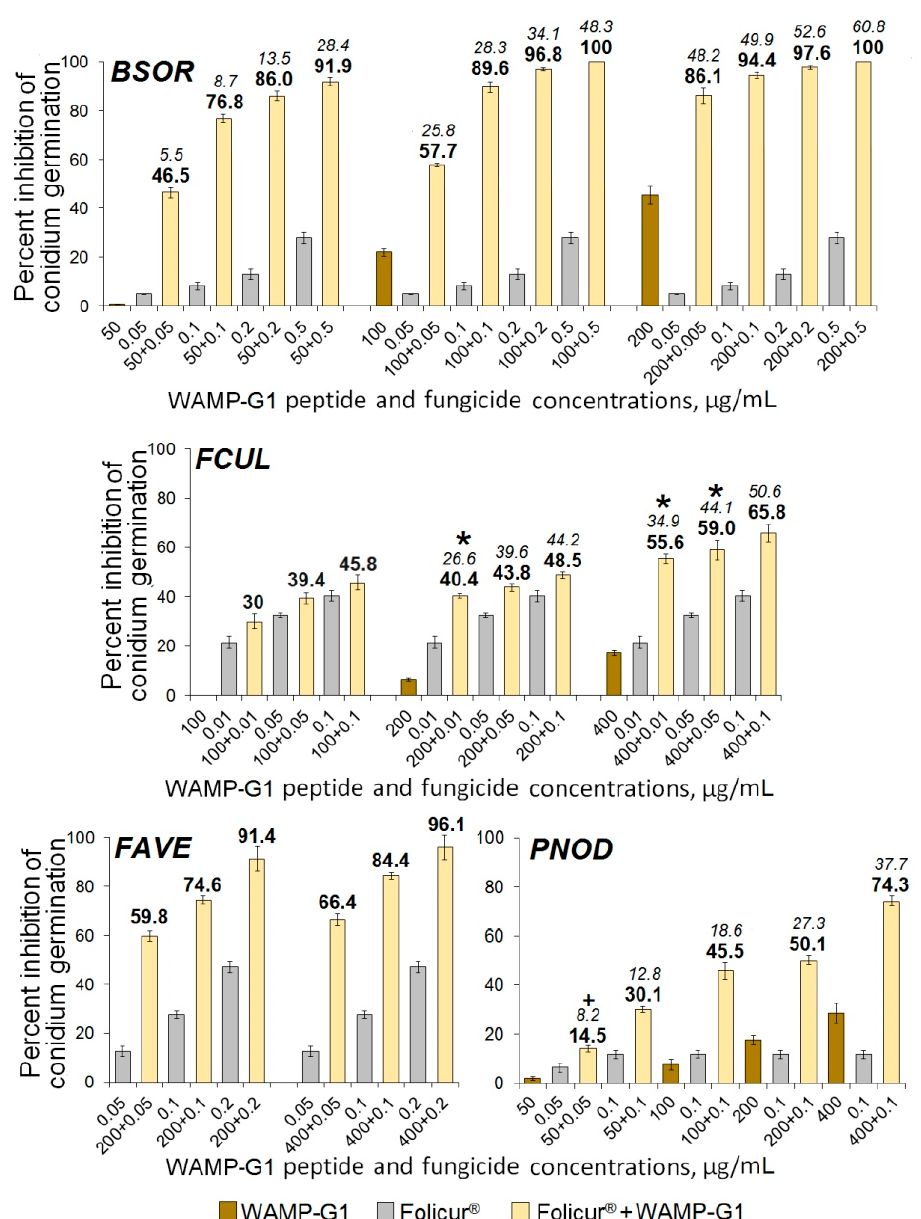
Figure 8. Histograms illustrating Folicur ® effect on germination of conidia in four cereal-damaging fungi after the combined application of the fungicide and WAMP-G1. BSOR , FCUL , FAVE , and PNOD are B. sorokiniana , F.culmorum , F. avenaceum , and P . nodorum , respectively. In the case of FCUL , the peptide–fungicide concentration combinations resulting in synergistic interaction are marked with asterisks, while the case of an additive effect towards PNOD is indicated by plus. For additional explanations, see caption to Figure 6.